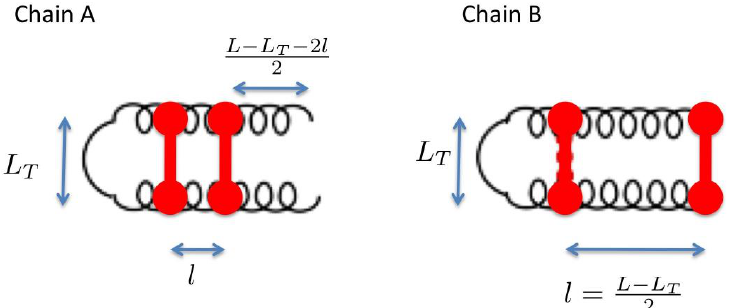
Figure A1. Schematic representations of the two homologous proteins considered in the analytically solvable